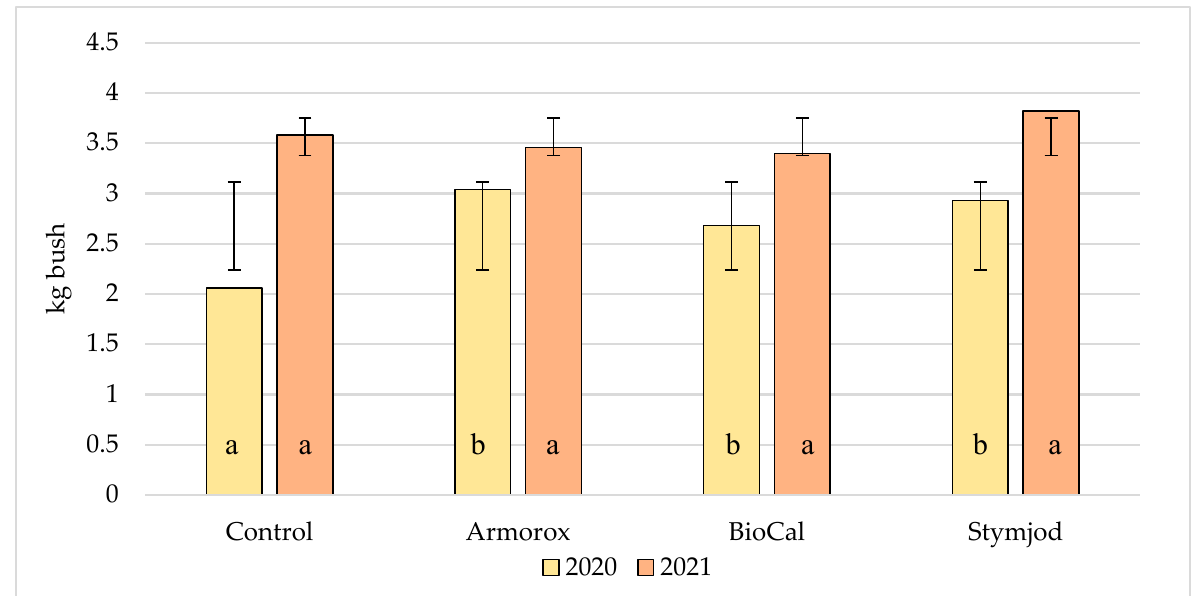
Figure 2. Yielding of blueberry bushes (kg bush) in 2020 and 2021. The mean values marked with the same letters did not differ significantly at a = 0.05.